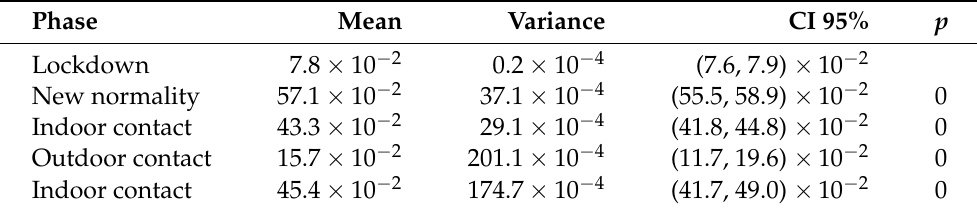
Table 12. Histogram for the mean values of β E at the different stages of lockdown in Spain.